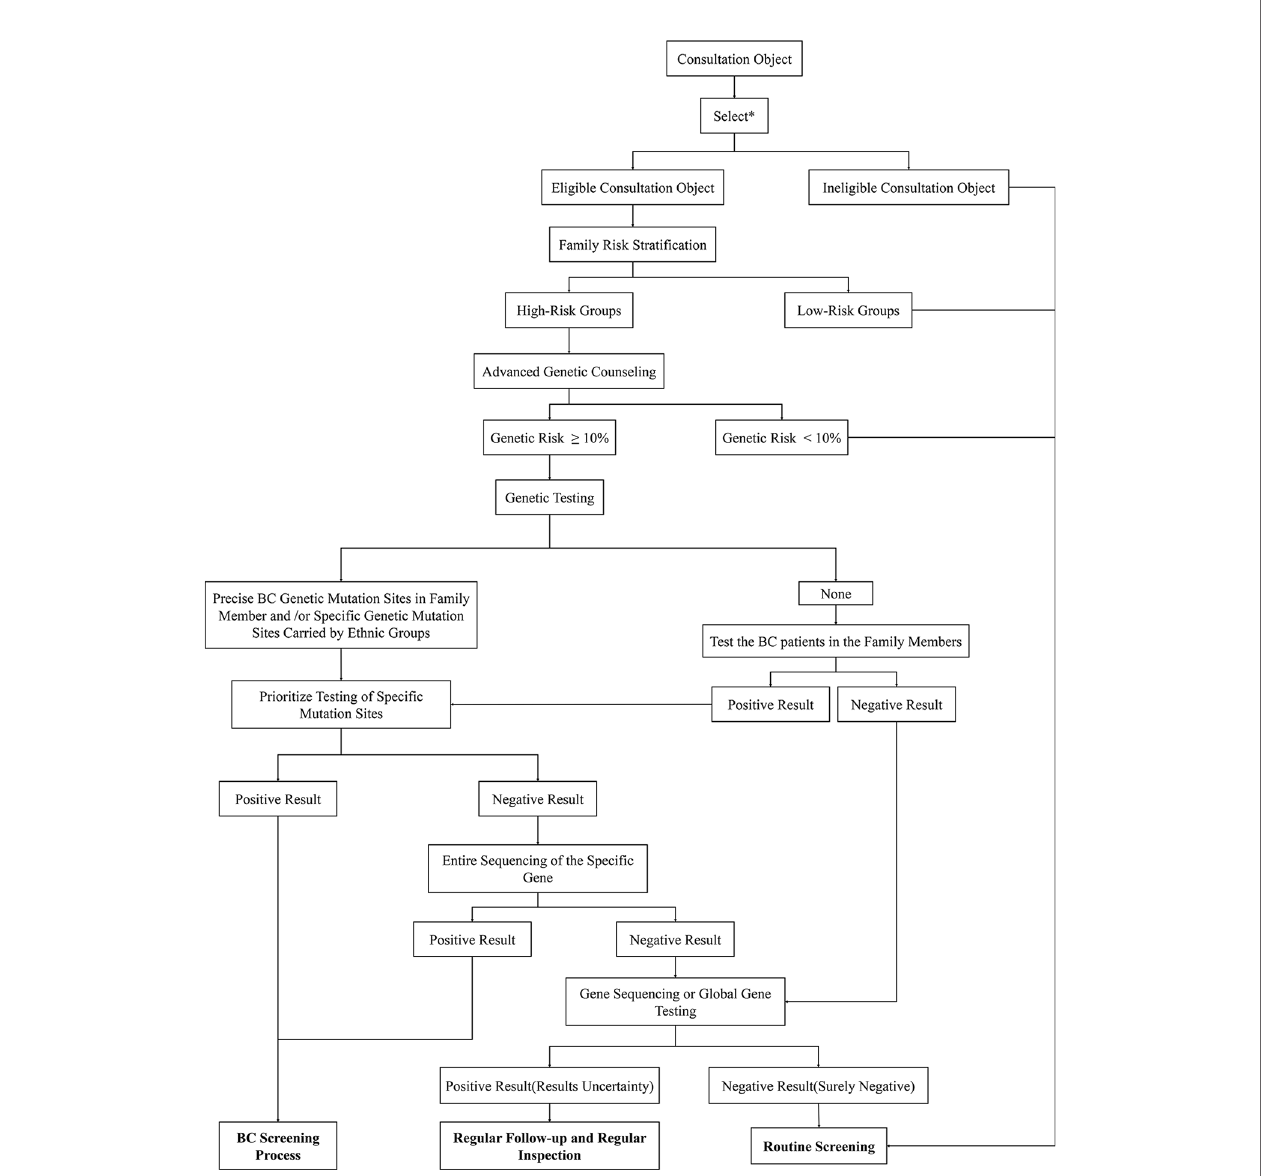
FIGURE 6 | Genetic counseling strategies for high-risk BCs in China. First, identify eligible consultation participants through the listed criteria. Then use risk strati fi cation tools to screen high-risk groups from the selected subjects. The lifetime risk of BC of these participants will be calculated through the risk assessment model in preliminary genetic counseling. High-risk subjects with a disease risk greater than 10% will be further subjected to follow-up genetic testing. Genetic testing gives priority to the detection of high-risk mutant gene sites in individuals of a family or Chinese populations. If obvious abnormalities are found, then speci fi c mutation sites can be considered, which should undergo the BC screening process; if there are no abnormal fi ndings, the entire sequence can be considered. In addition, the positive subjects receive BC screening while the negative participants receive whole genome sequencing. The fi nal genetic test results need to be compared with the genetic test results of patients with BC in the family. If the mutant gene is the same, the consultation subject is con fi rmed to be in the high-risk group; if the results are inconsistent, the subject will not be listed as high-risk for the time being. For those whose family members have not been tested for genetic mutations, the fi rst step is to detect the mutated gene sites in patients with BC. If the family member cannot be tested or the test result is negative, whole-genome sequencing can be performed. If there are clear mutation sites in the family members with BC, priority will be given to monitoring these gene sites. The subsequent detection steps are the same as those described above. Result analysis: 1. Positive Result (The consultation participant showed clear mutation genes that were consistent with those of a family member or ethnic group): Corresponding measures can be taken to actively intervene in the clinic; 2. Uncertainty negative (no obvious abnormality was found in the gene testing, but whole genome sequencing was not performed due to other factors): regular clinical follow-up; 3. Results Uncertainty (the patient found clear mutation genes but inconsistent with family): Regular clinical follow-up; 4. Surely negative (no abnormality was found after all inspections were completed): Routine examination. *The selection criteria are shown in Figure 7